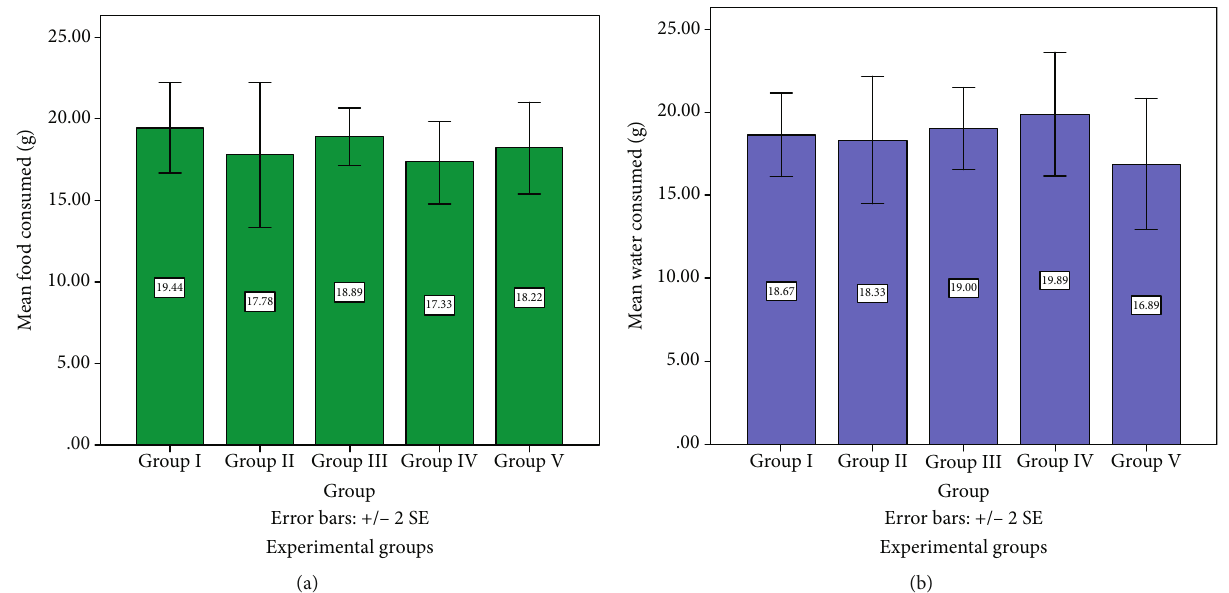
Figure 4: (a, b) Food and water intake of experimental mice (DMBA-induced mice signi fi cantly ( p < 0 : 05 ) reduced the food and water intake; FA-treated mice signi fi cantly ( p < 0 : 05 ) increased the food and water intake).